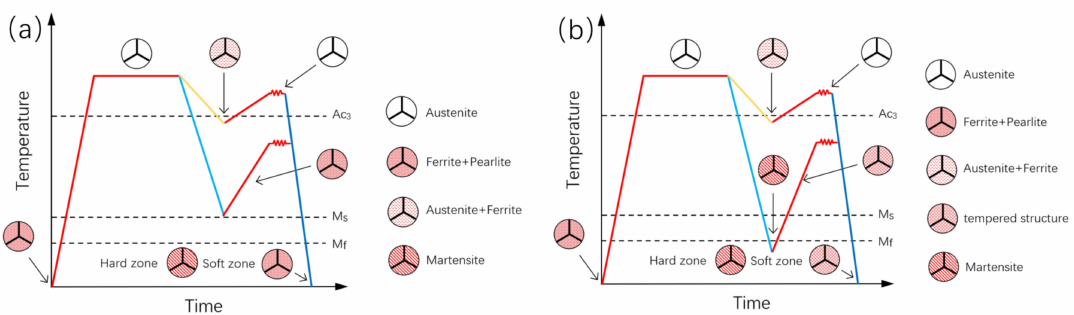
Figure 1. ( a ) TPP-S; ( b ) TPP-F. Red lines (heating and isothermal), Yellow lines (slow cooling), blue and dark blue lines (fast